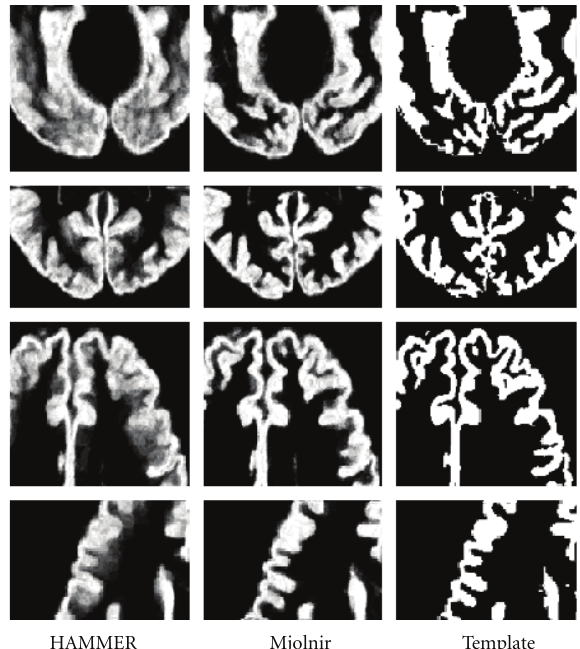
Figure 13: The distribution of the aligned gray matter. The gray matter of the template is shown on the right column for comparison. Evidences of large outlier errors are visible in the result generated by HAMMER (see blurring of boundaries).